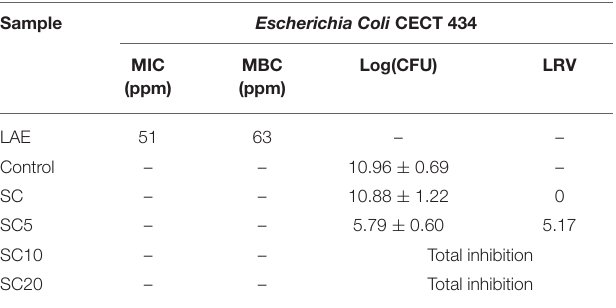
TABLE 3 | Minimum inhibitory concentration (MIC) and minimum bactericidal concentration (MBC) of LAE against E. Coli , and antimicrobial activity for the SC coated films at 0, 5, 10, and 20% LAE concentration., expressed as logarithm of colony forming units (Log(CFU)) and log reduction value (LRV).